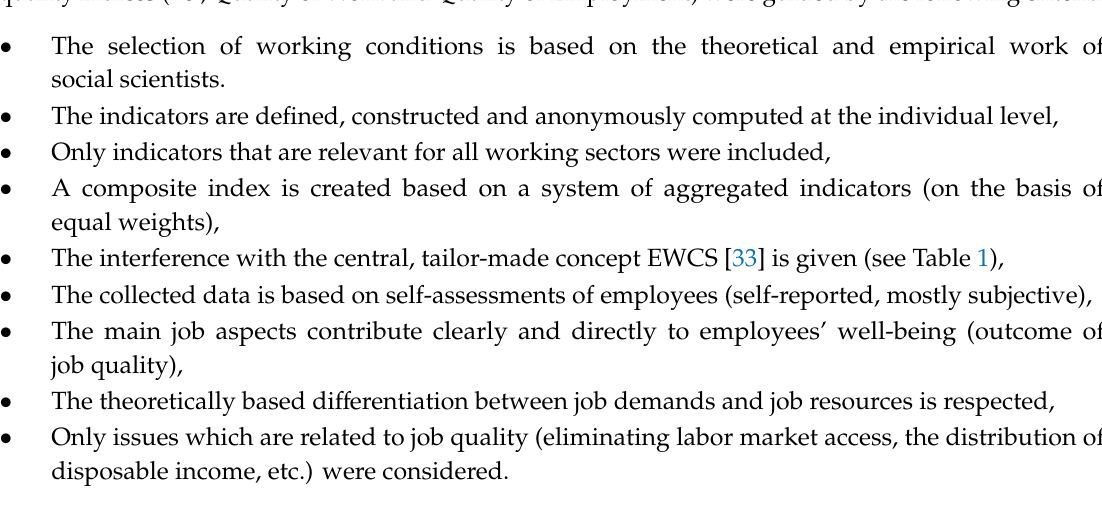
Table 1. Areas and dimensions of the Quality of Work Index Luxembourg in comparison with job quality (EWCS; Eurofound, 2016).